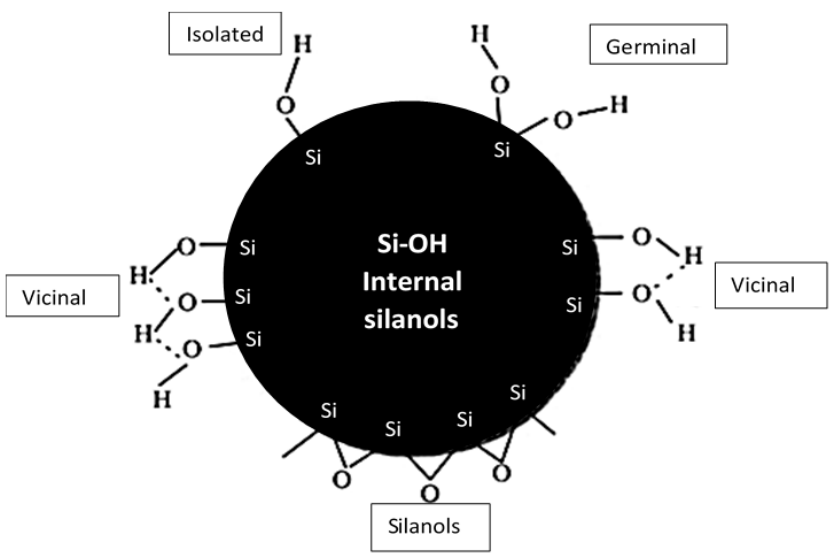
Figure 2. Different types of groups on the silica surface. Figure 2. Di ff erent types of groups on the silica